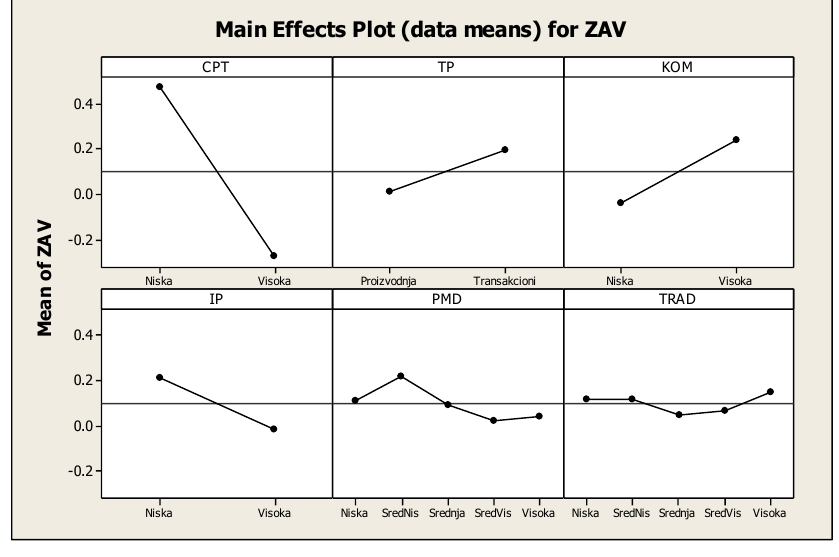
Fig. 7. Main effects plot for ZAV